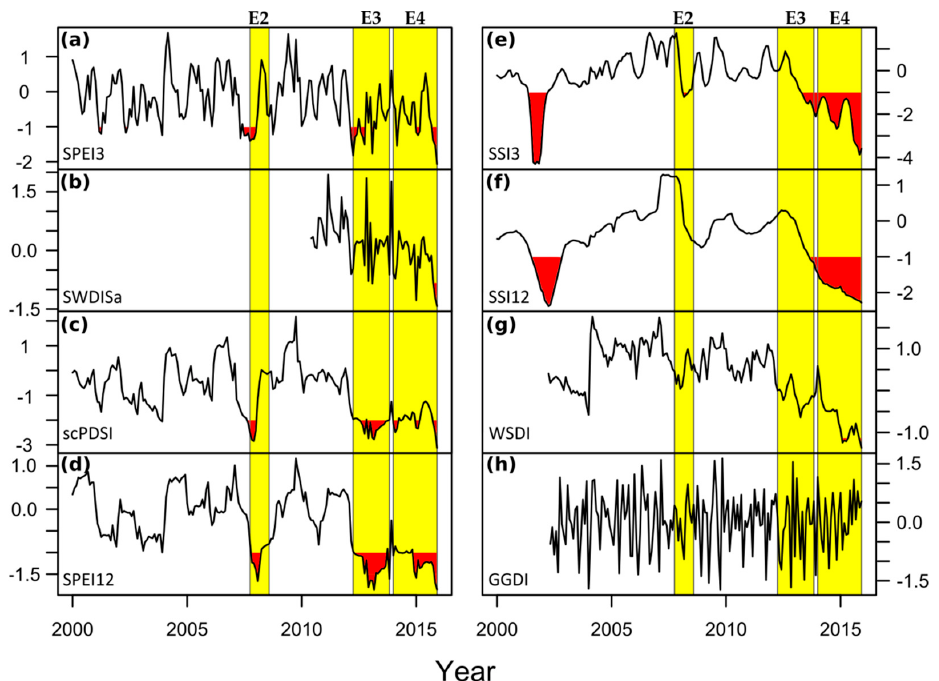
Figure 8. Temporal variation of the area-averaged values over the entire SFRB of the ( a ) SPEI3 during 2000–2015, ( b ) SWDISa during 2010–2015, ( c , d ) scPDSI and SPEI12 during 2000–2015, ( e , f ) SSI3 and SSI12 at the streamflow gauge Propriá during 2000–2015, and ( g , h ) WSDI and GGDI during 2002–2015. The yellow shaded periods on the panels ( a ) to ( h ) indicate the occurrence of the SPEI12- based extreme drought events E2, E3, and E4 shown in Table 3. Red shaded area corresponds to drought conditions for each drought index (see Table 3).